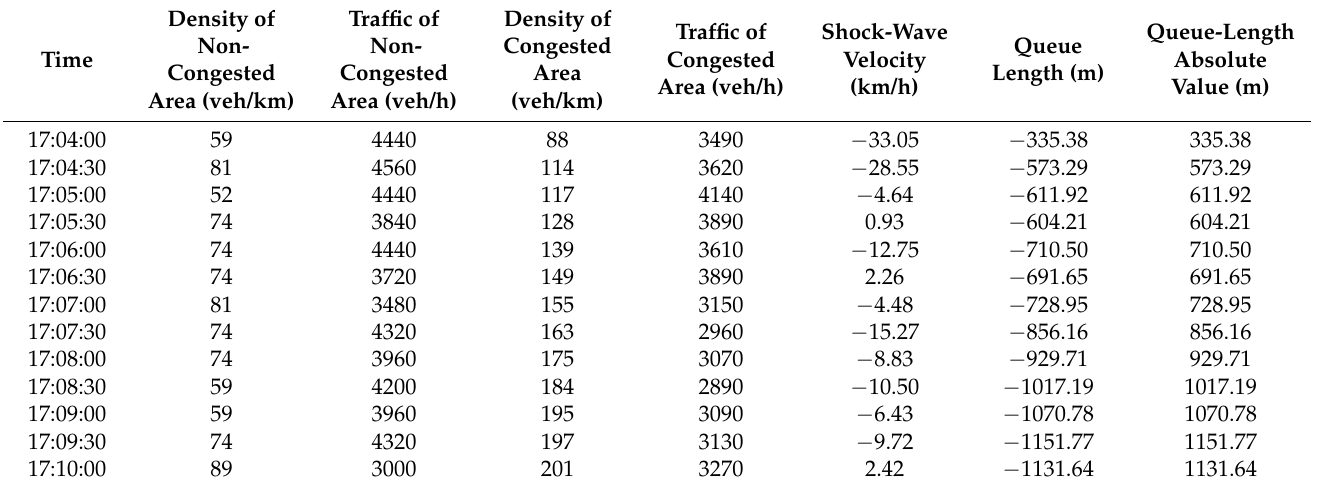
Table 3. Table of vehicle queue length estimation process when the time interval is 30